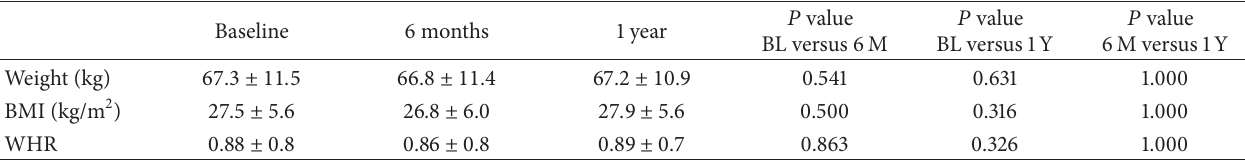
Table 1: Anthropometric characteristics (mean, standard deviation) of participants at baseline, after 6 months, and after 1 year of exercise intervention.